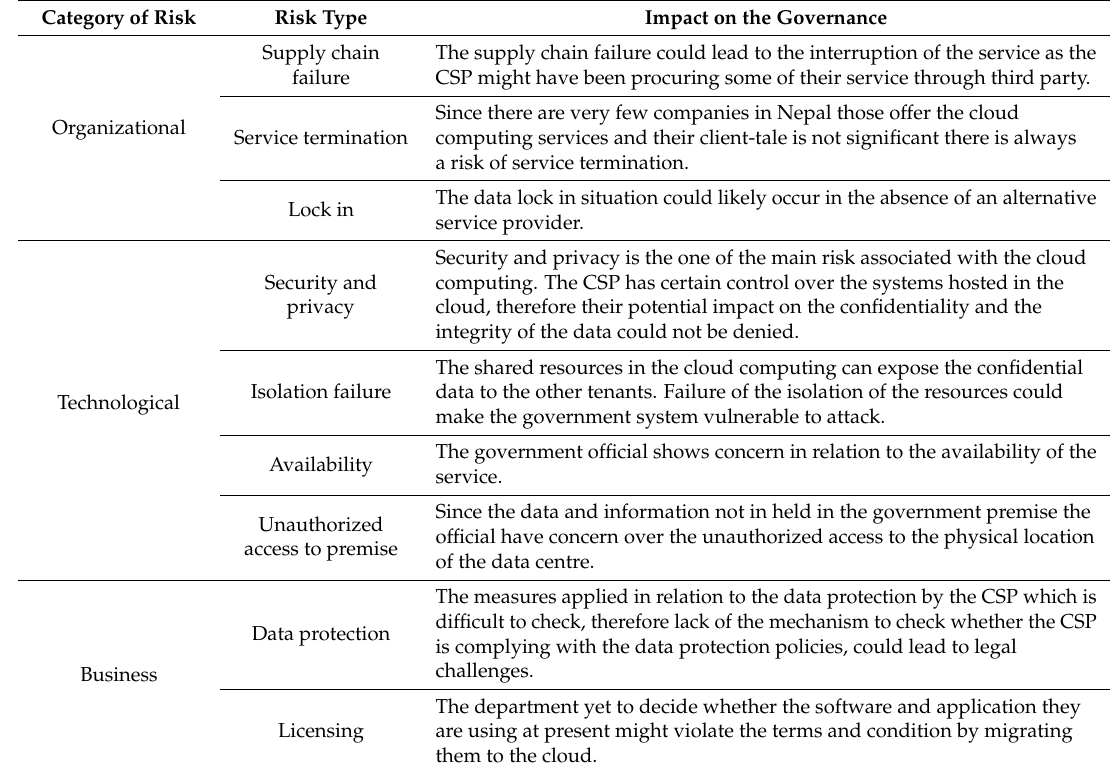
Table 4. Risk assessment for cloud service